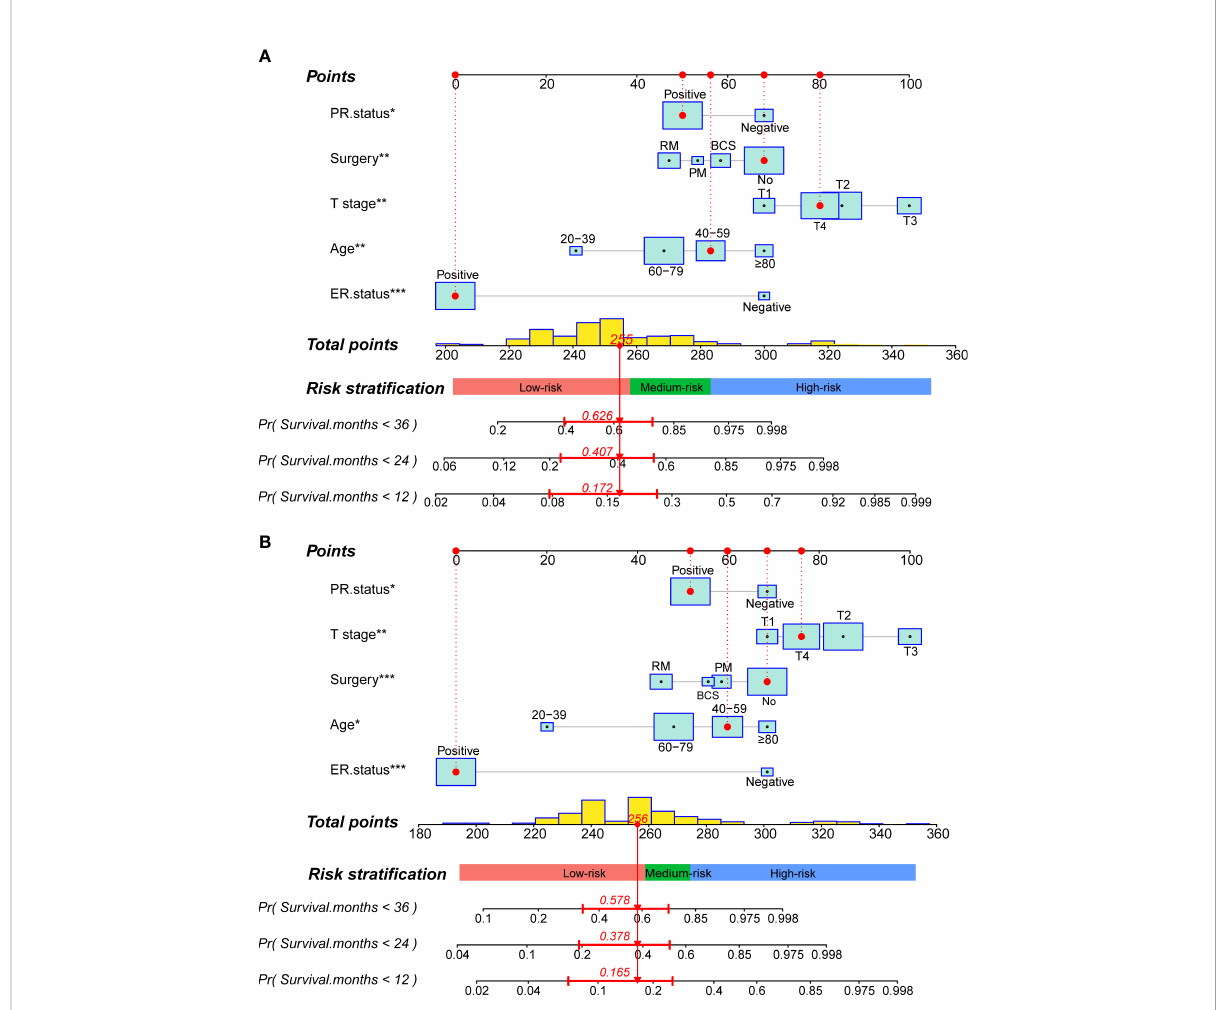
FIGURE 4 Construction of two prognostic nomograms for predicting the 12-,24- and 36months OS and CSS in MBCBM patients. (A) The prognostic nomogram for OS. (B) The prognostic nomogram for CSS (***:P < 0.001; **:P < 0.01; *:P < 0.05; BCS, breast-conserving surgery; PM, partial mastectomy; RM, radical